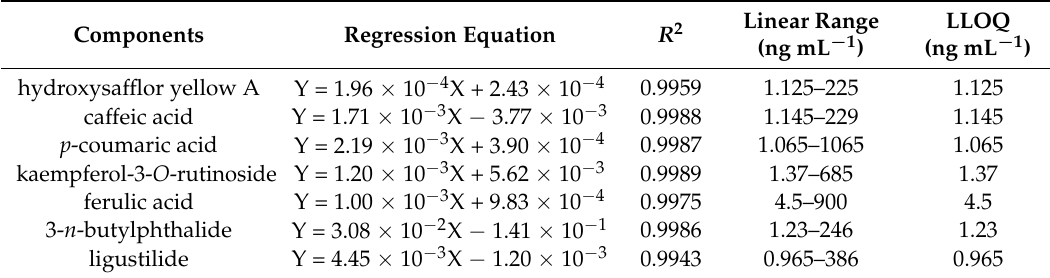
Table 2. The regression equation, linear range, and LLOQ of the seven components in rat plasma samples.